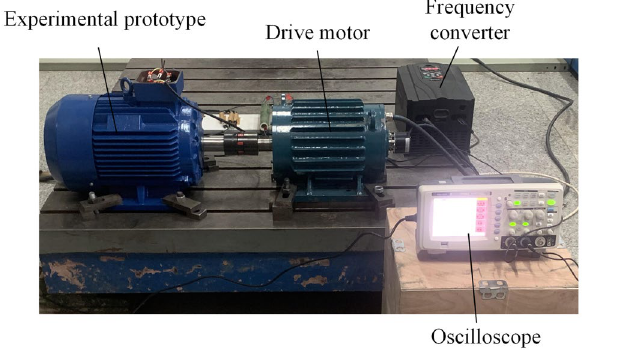
Figure 13. FPGM prototype experimental